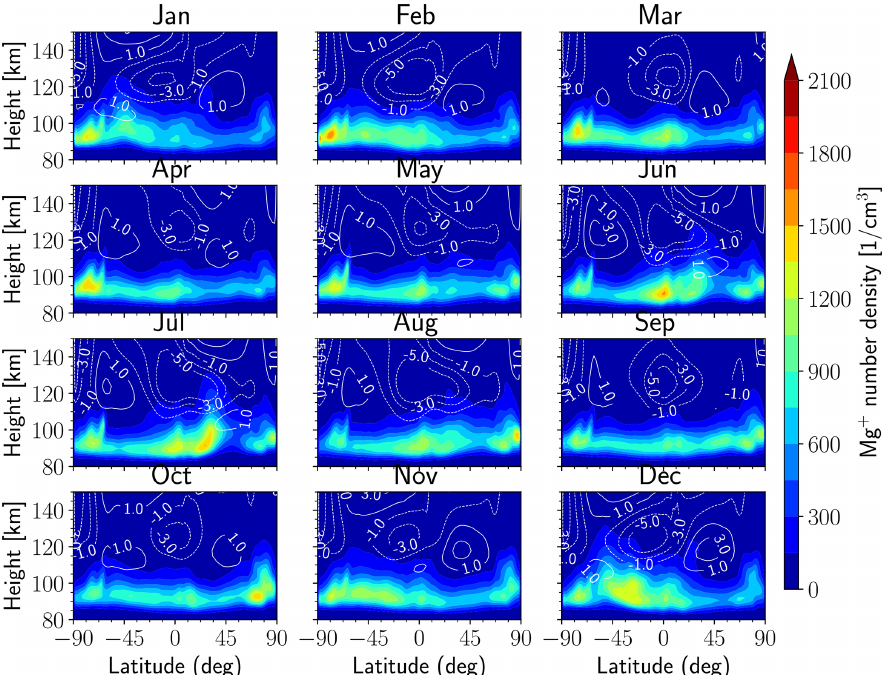
Figure 1. Monthly and zonal mean of the Mg + number density (coloured contours) and the drift velocity (in ms − 1 ) due to the neutral wind (line contours) as a function of latitude and altitude in different months.